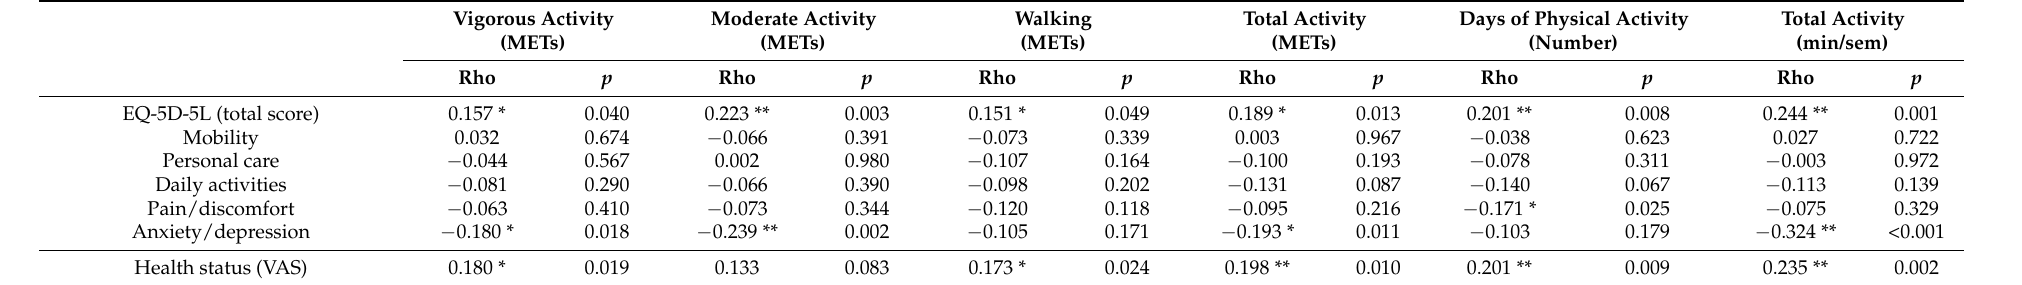
Table 5. Correlations between EQ-5D-5L and IPAQ questionnaires in the Type 1 Diabetes Mellitus population ( n = 172). Vigorous Activity